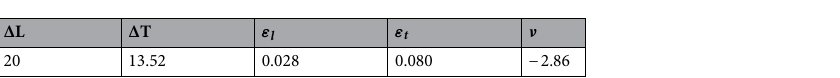
Table 5. Measured displacements, strains and Poisson’s ratio of auxetic composite in the case of tensile test.